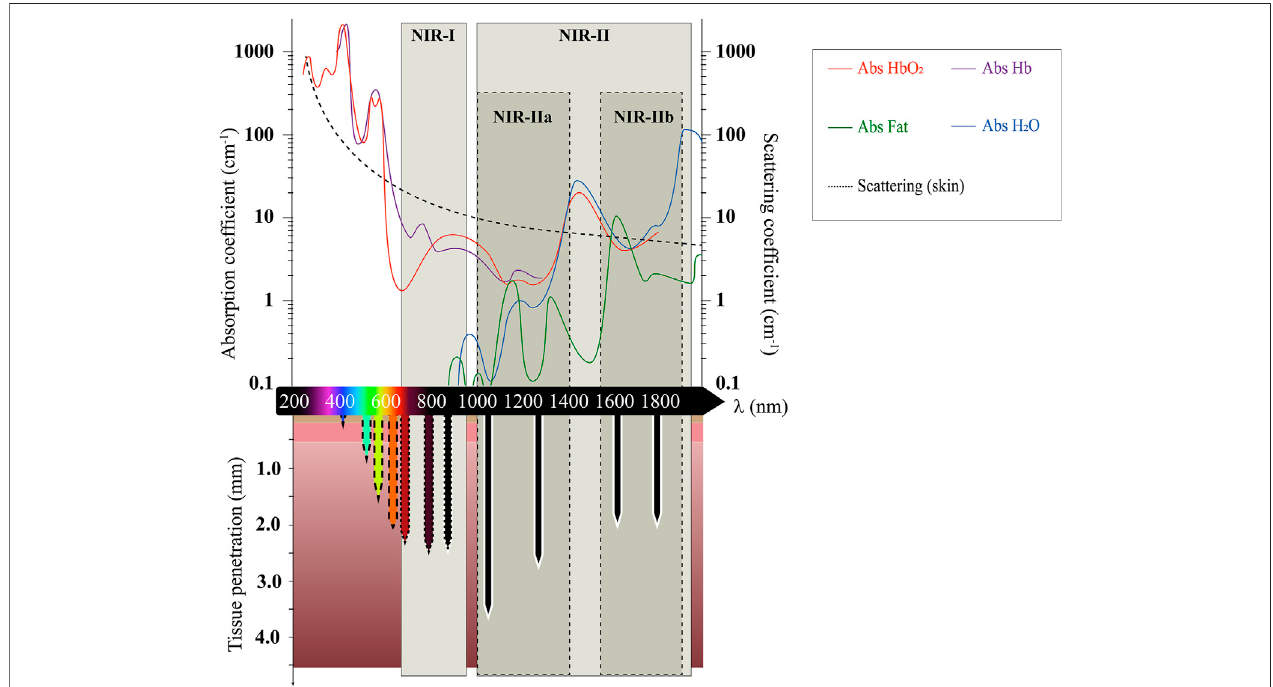
FIGURE 1 | Absorption and scattering coef fi cients of endogenous chromophores, tissues, and water over the visible and SWIR wavelengths (200 – 2000 nm). The downwards arrows represent the tissue penetration of light at these wavelengths, according to the values reported for human skin in ref. (Bashkatov et al., 2005). Dashed, dotted and solid outlines on penetration arrows represent the increase in imaging resolution with increased wavelengths. Adapted from values reported in ref (Jacques, 2015). and references therein.